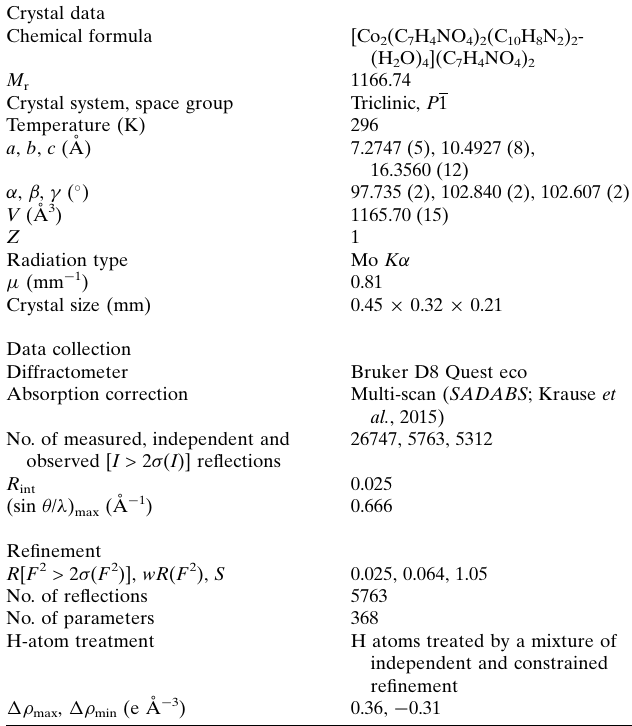
Table 2 Experimental details. Crystal data Chemical